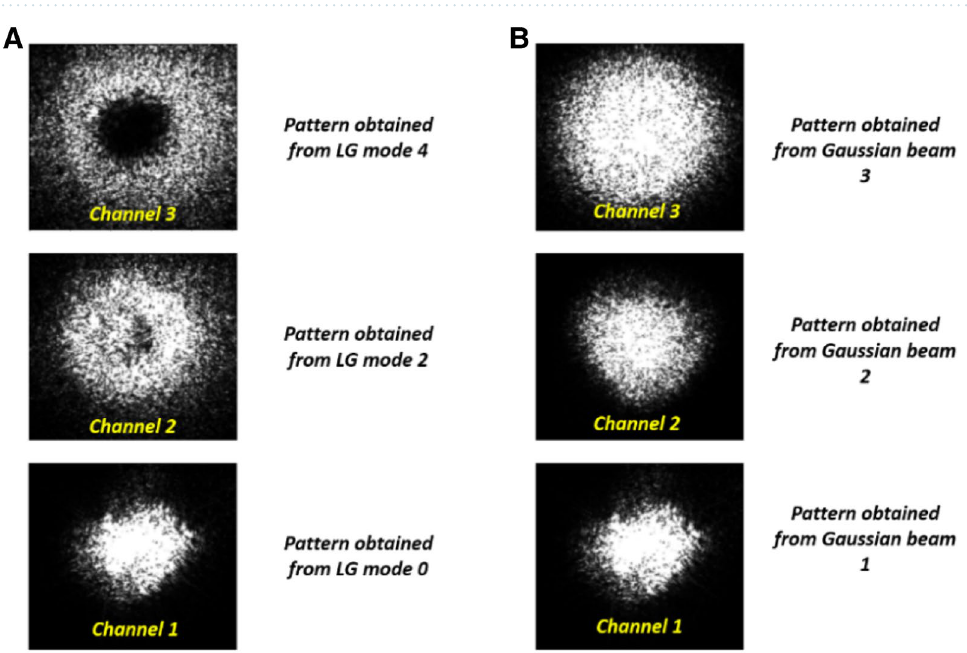
Figure 8. ( A ) and ( B ) Show the multimodal images captured by the beam profiler of the LG modes and the corresponding Gaussian beam modes in the experiment. The changes in the contrast of the images as compared to the simulated images is due to the difference in the colorbar and exposure settings of the beam